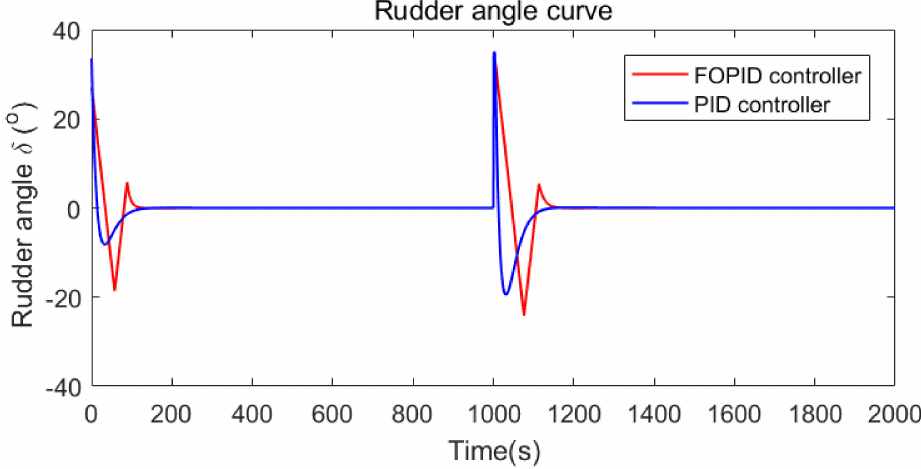
Figure 13. Rudder angle curves with FO PI λ D µ controller and PID